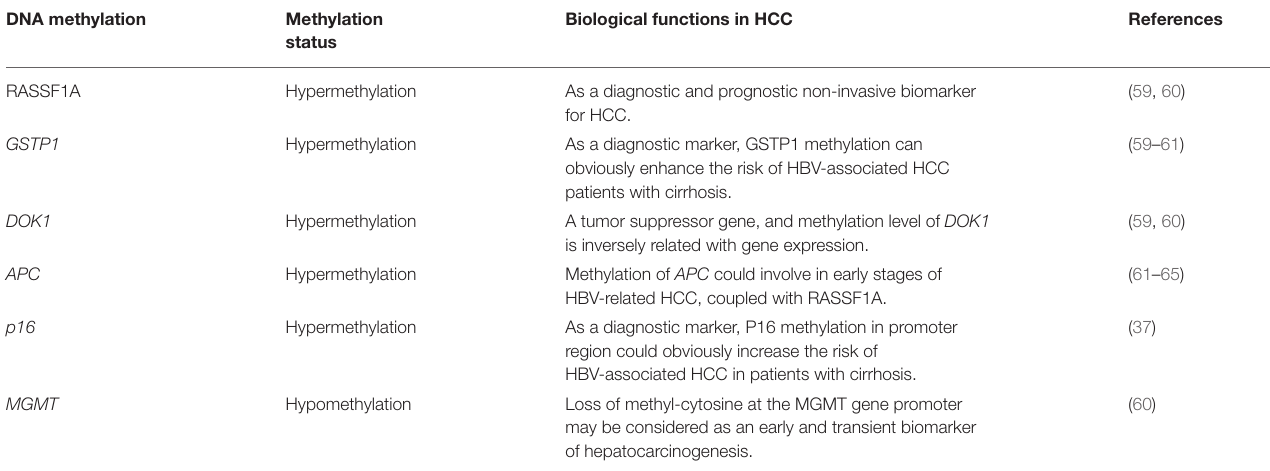
TABLE 2 | DNA methylation in HBV-associated